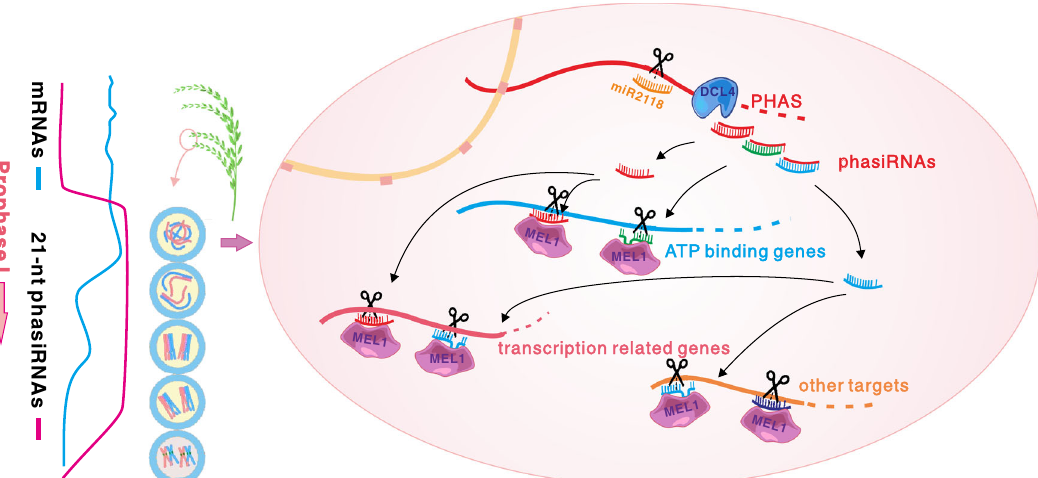
Fig. 6 A working model for reproductive phasiRNAs which cleave and regulate target genes during meiotic prophase I in rice. 21-nt phasiRNAs exhibit a burst of expression in in fl orescences from the premeiosis stage and to decrease in expression at the end of meiosis, when extensive gene expression changes occur. They are essential for trans RNA cleavage and mRNA elimination during meiotic prophase I. The phasiRNAs prefered to target to ATP binding genes and transcription related